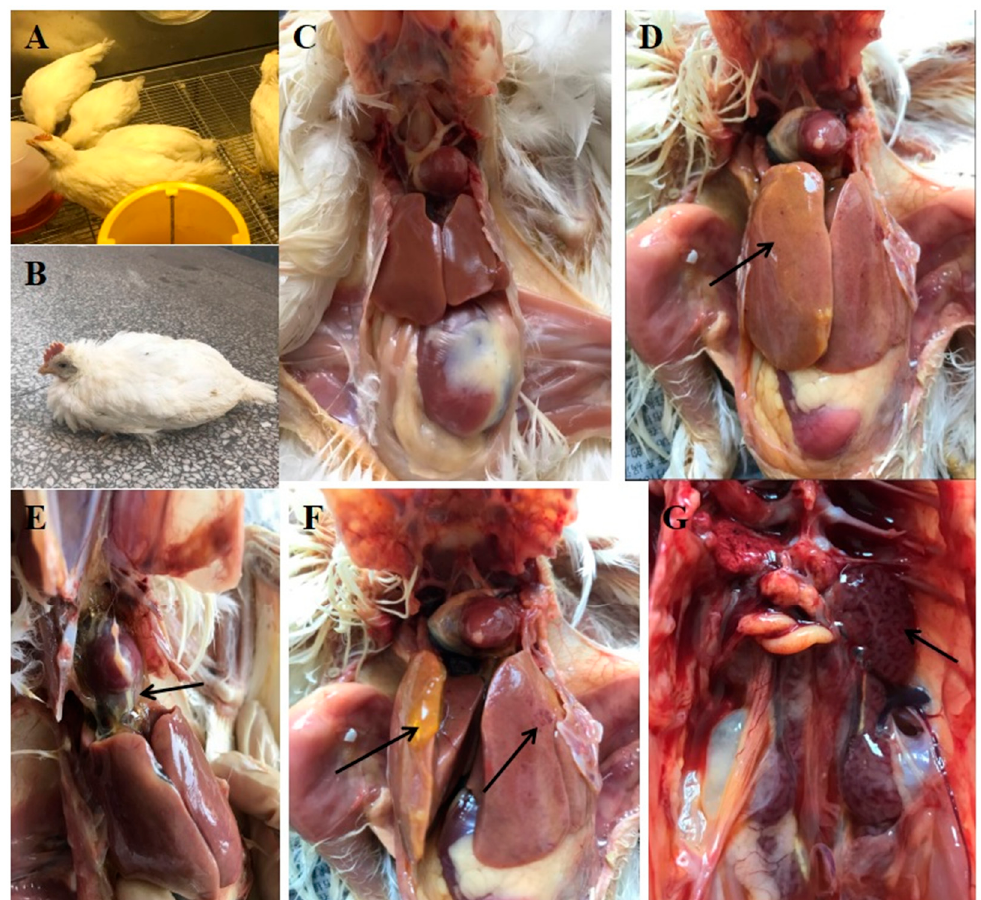
Figure 3. Clinical symptoms and gross pathology of FAdV-4 SDJN0105-infected chickens and uninfected controls. ( A , C ) Healthy chicken from the control group. ( B ) Lethargy, depression, and ruffling of neck feathers as seen in an SDJN0105-infected chicken. ( D , F ) Yellow jelly or watery-like exudate in the liver and liver degeneration and necrosis. ( E ) Amber colored liquid or water-like transparent exudate in the pericardial sac. ( G ) Renal hemorrhage and swelling.